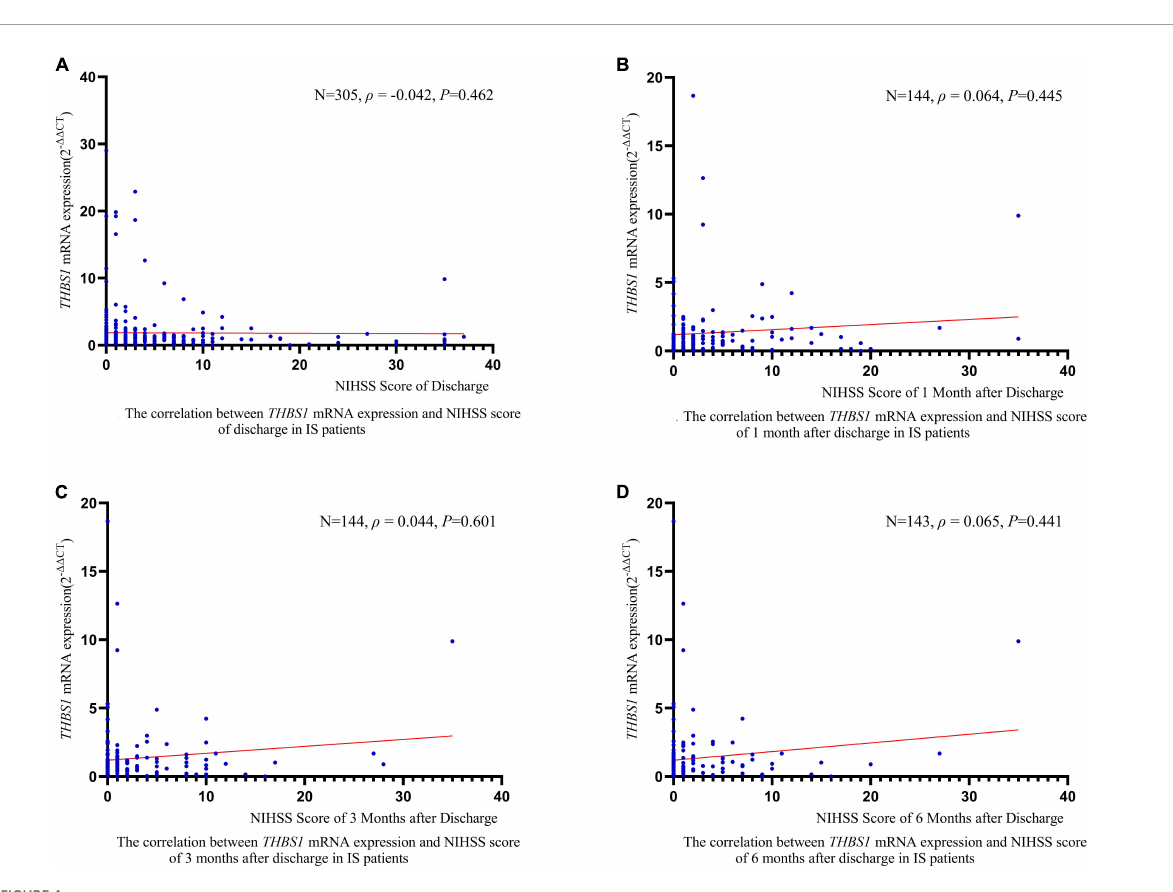
FIGURE4 The correlation between THBS1 mRNA expression and NIHSS scores of different periods after discharge in IS patients. THBS1 mRNA expression has no significant relevance to NIHSS scores of different periods after discharge in IS patients (all P -values >